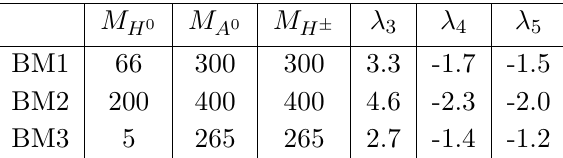
benchmark scenarios in the ( λ ) plane along with the contours by hγγ decay and , M 3 H ± Zh precision measurement in figure 7. The legends “L1, L2, L3” on the right hand side of the figure denote the contours by Zh precision measurement (i.e., | δσ fixed λ and λ in accordance with that in “BM1, BM2, BM3”, respectively. One can 4 5